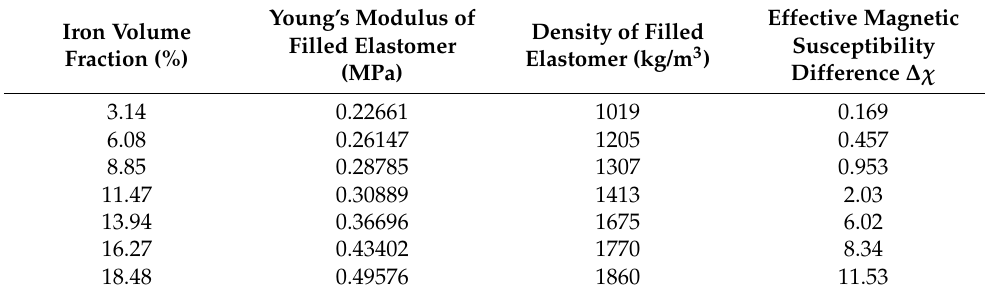
Table 1. Experimentally-measured material properties of magnetorheological elastomers with differ- ent volume fractions (Poisson’s ratio as 0.48)